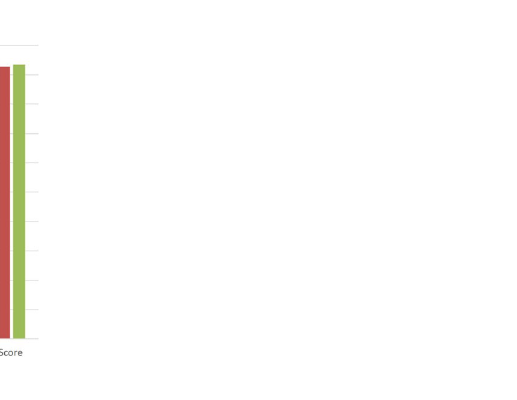
Figure 4. The ROC curves of PLPIHS method under three different levels of sparse